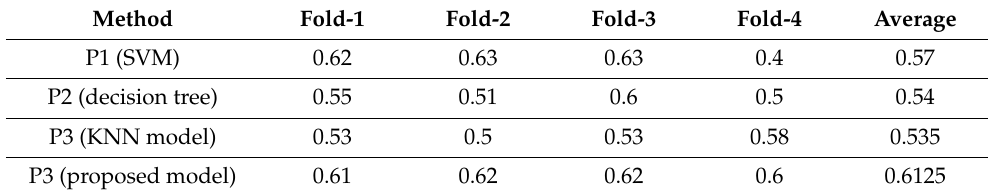
Table 3. Sensitivity of the proposed predictive